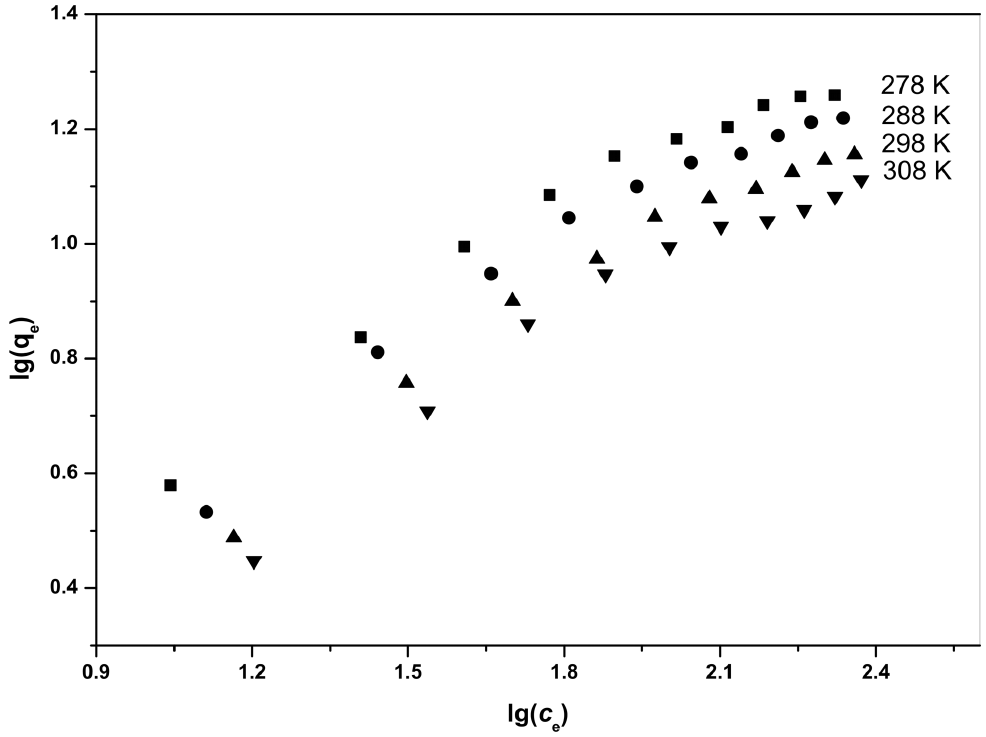
Figure 5. Freundlich isotherm plots for Cd 2 + biosorption at different temperatures.